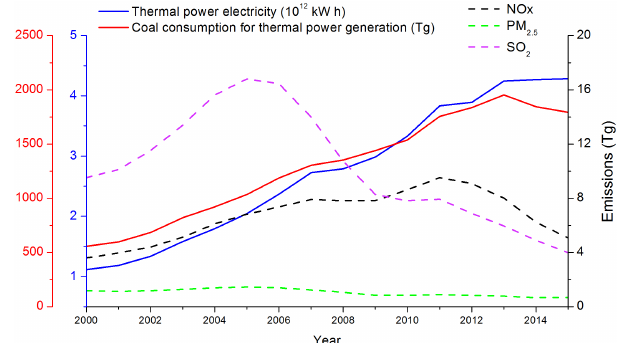
Figure 2. Coal-fired power electricity and associated coal consump- tion for power generation, and the emissions of NO x , SO 2 , and PM 2 . 5 from thermal power plants from 2000 to 2015 in China.